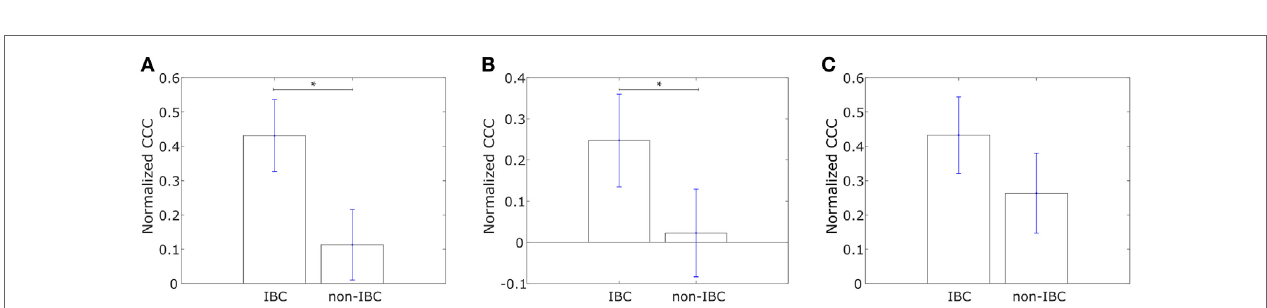
FigUre 4 | Normalized cophenetic correlation coefficient of the inflammatory breast cancer-associated gene network for tumor samples from IBC patients and non- IBC breast cancer patients for data from studies by (a) Iwamoto et al. (45) with 25 IBC and 57 non-IBC breast cancer patients, (B) Boersma et al. (46) with 13 IBC and 35 non-IBC breast cancer patients, and (c) Woodward et al. (24) with 20 IBC and 20 non-IBC breast cancer patients. Error bars indicate the SE in the estimate of CCC norm calculated using the bootstrap method. * p -Value < 0.05.